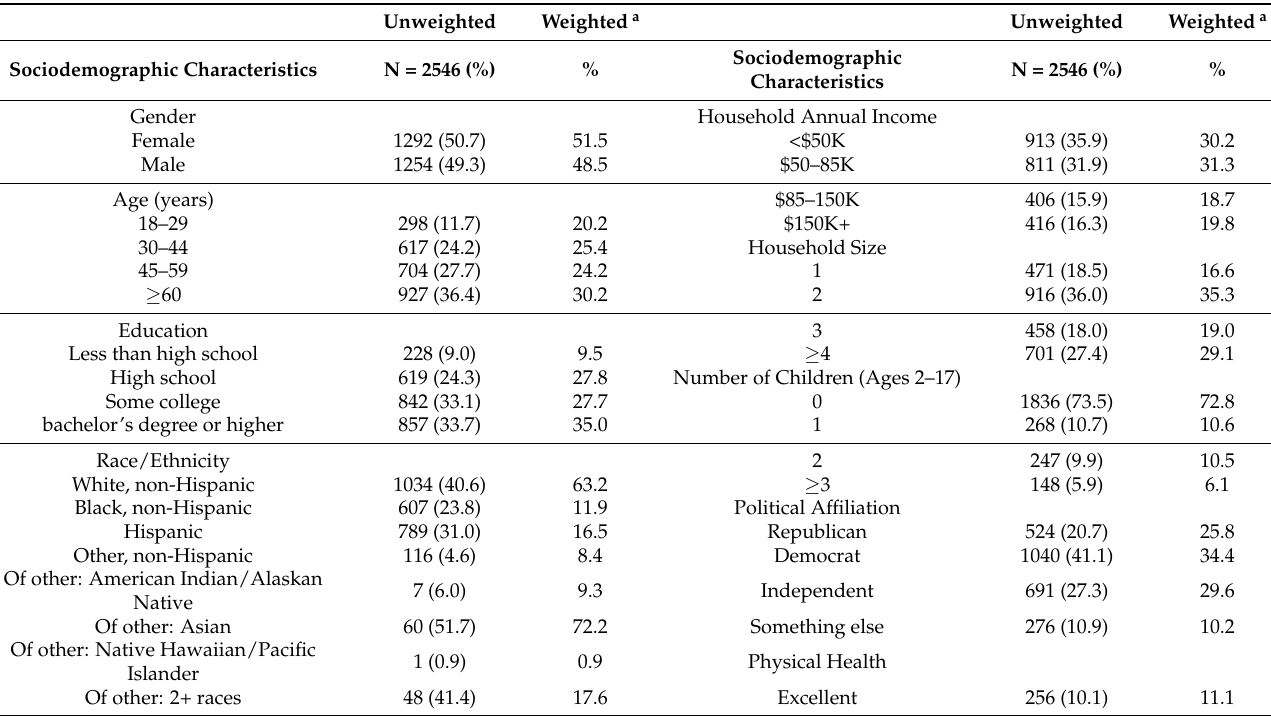
Table 1. Sociodemographic Characteristics and Vaccination/Disease Status of the September 2021 Sur- vey Sample: Unweighted and Weighted. The numbers of survey participants are listed by sociodemo- graphic characteristics and vaccination/disease status. Survey weights were used so that the data were representative of US adults; specifically, Black and Hispanic respondents were weighted to adjust for oversampling performed to allow for stratified analyses with sufficient power. Unweighted and weighted percentages are presented for